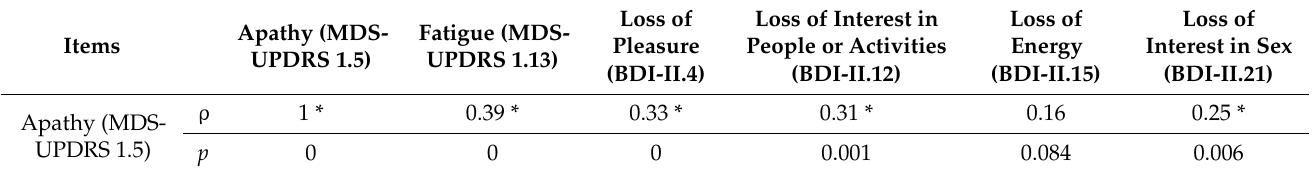
Table 2. Correlations between apathy and apathy-related